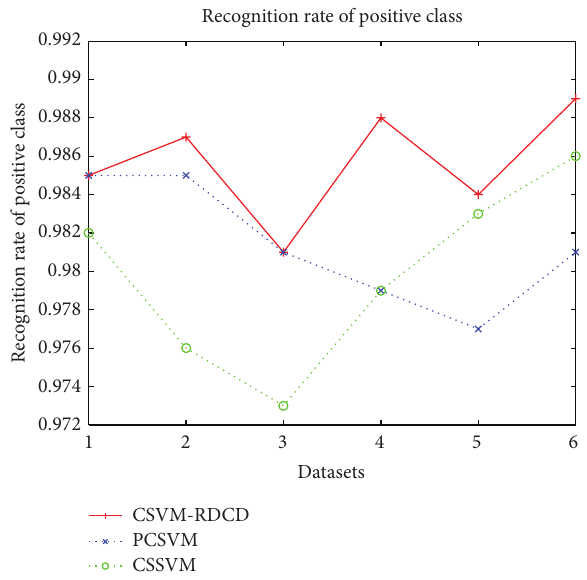
Figure 2: The positive class recognition rate comparison of three algorithms using